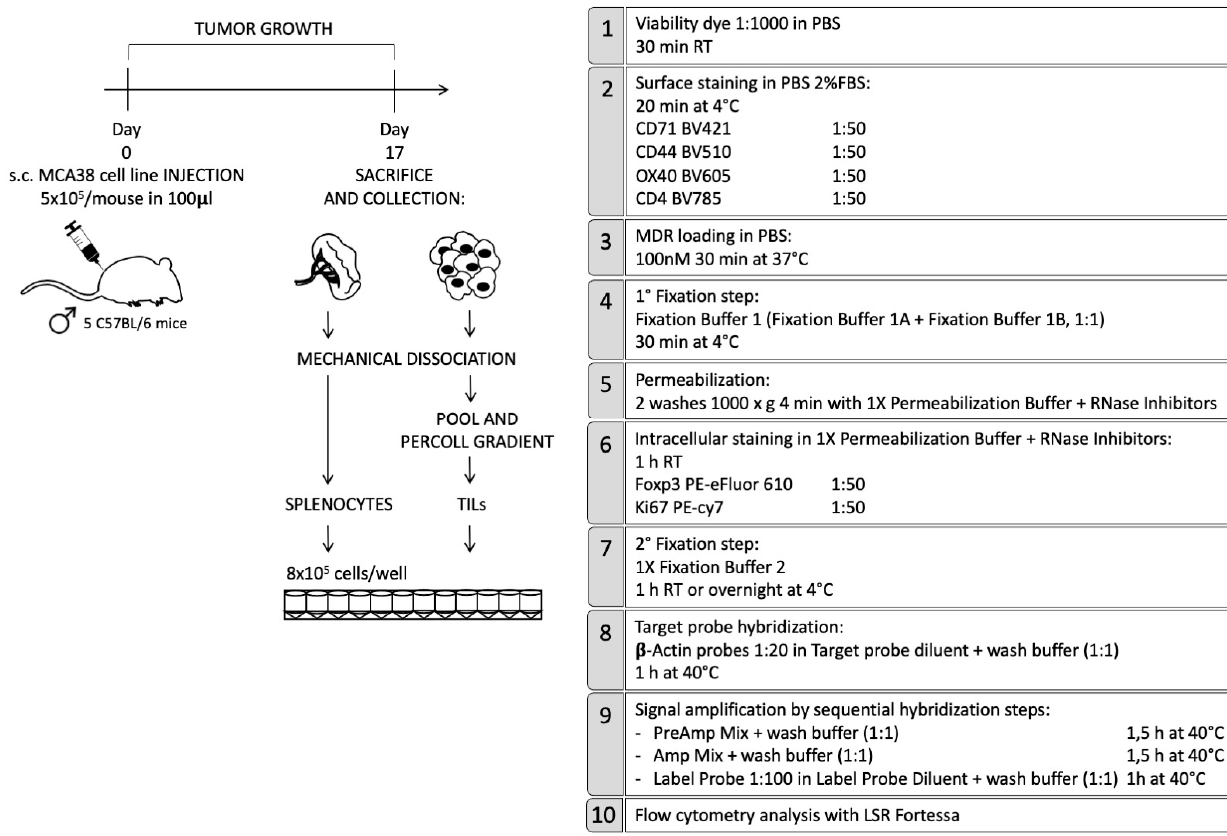
Figure 2. Workflow of the combined staining of surface and nuclear markers, mitochondria and specific mRNAs. PBS, phosphate buffered saline.